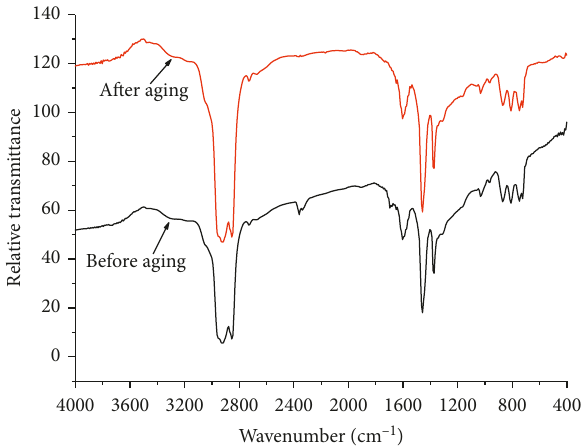
Figure 10: FTIR spectra of WPP/OREC-1.5-modified asphalt before and after